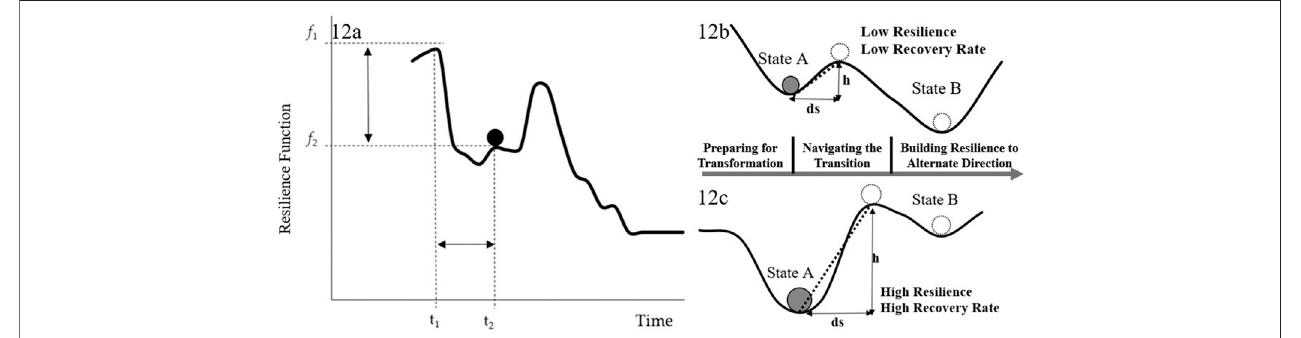
FIGURE12|(A) StagesintheperformanceofFEWStowardresilienceinresponsetodisturbanceswith (A) tippingpointst1andt2andcriticalthresholdsf1andf2 which are overcome by changing the state of a system in response to drivers, and (B) and (C) show the systems with low and high resilience and recovery rate,